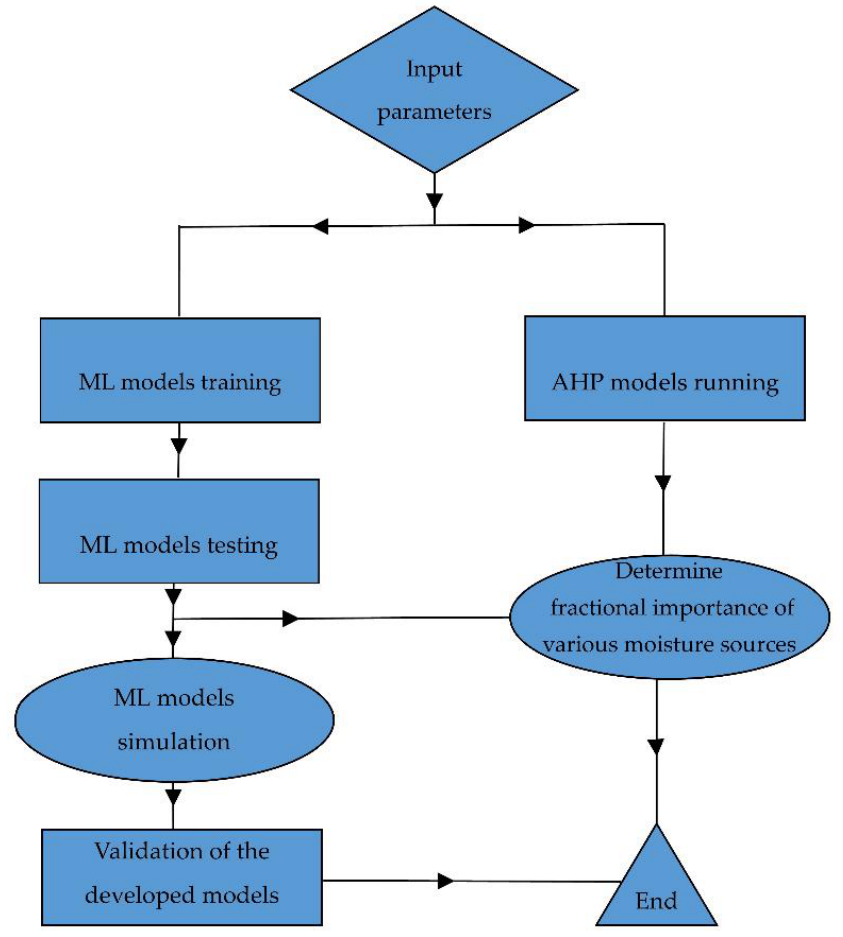
Figure 3. Flowchart demonstrates the procedure of this study.